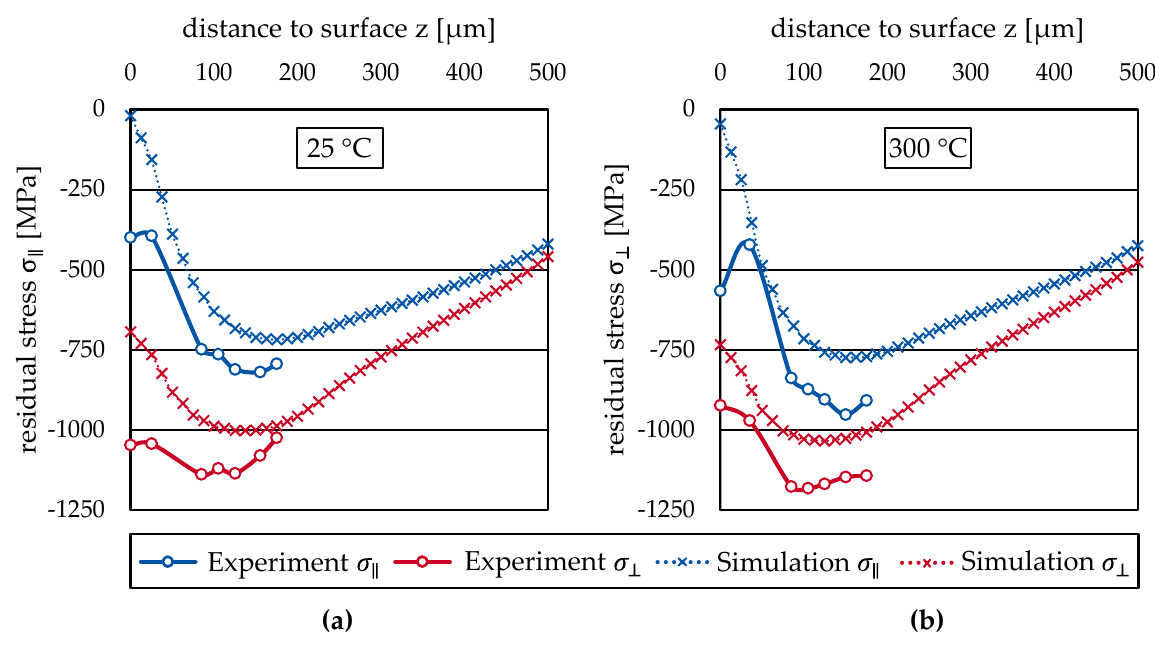
Figure 12. Comparison of simulated and measured residual stress depth profiles in deep rolling with F r = 1800 N at room temperature (25 °C) and 300 °C ( a ) for the residual stress parallel to the rolling direction, and ( b ) for the residual stress perpendicular to the rolling direction.